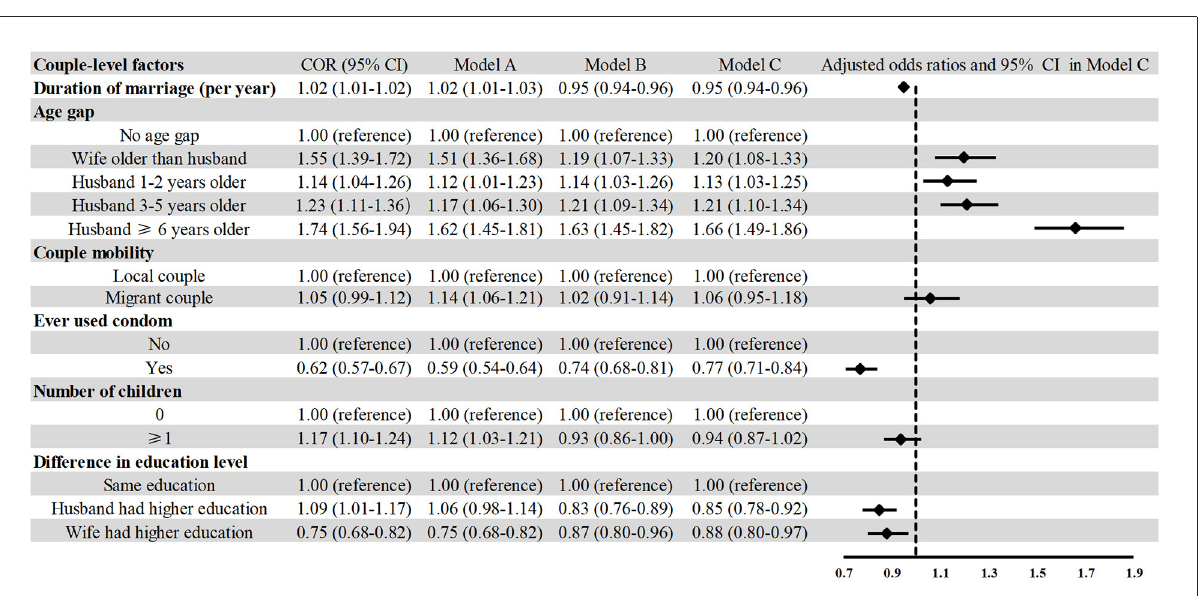
FIGURE4 Association between couple-level factors and syphilis infection among women who participated in the National Free Preconception Health Examination Project in Guangdong Province, China during 2014–2019 ( N = 1,755,156). Model A included only couple-level factors; Model B additionally adjusted for year of screening, age, ethnicity, educational level, household registration, smoking, drinking, migrant, illicit drug use, and previous STIs. Model C additionally adjusted for